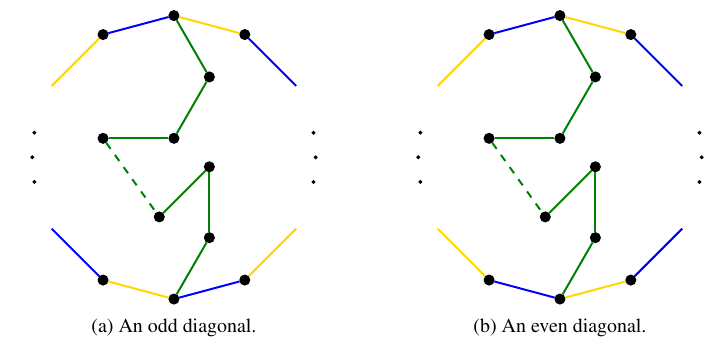
Fig. 4: Two kinds of diagonals in a B-Y